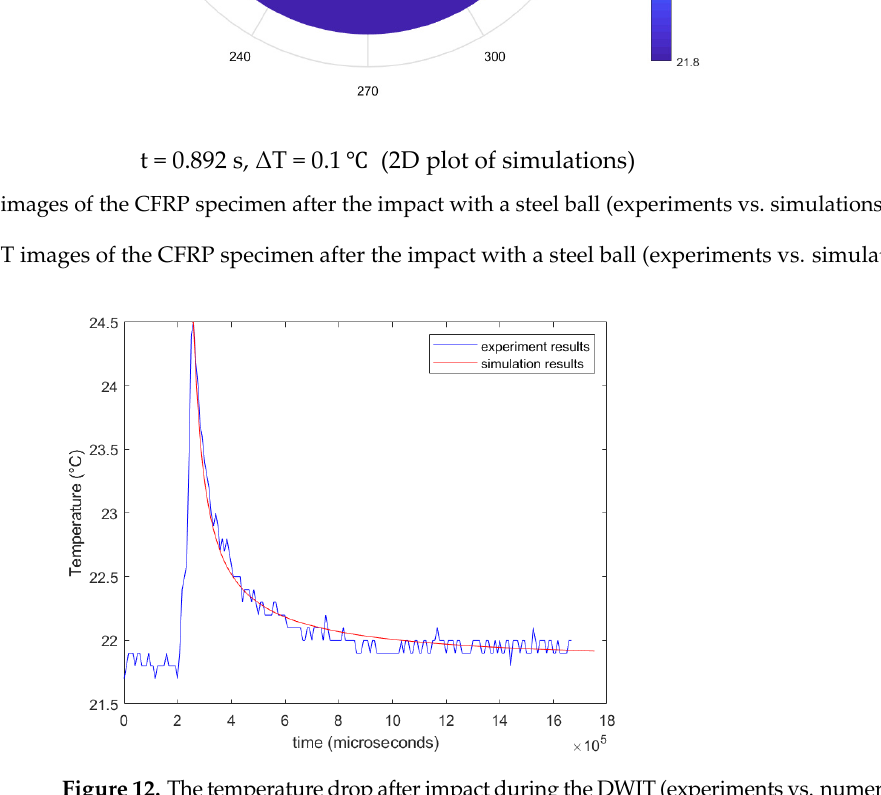
Figure 12. The temperature drop after impact during the DWIT (experiments vs. numerical simulations).